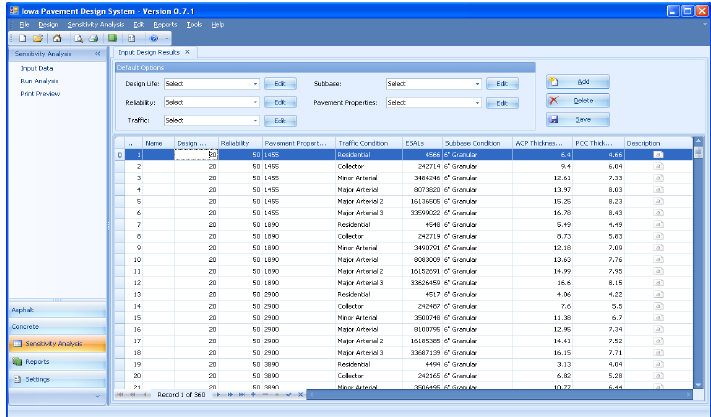
Figure 6. Screenshot of PDSA Pavement Design Database.